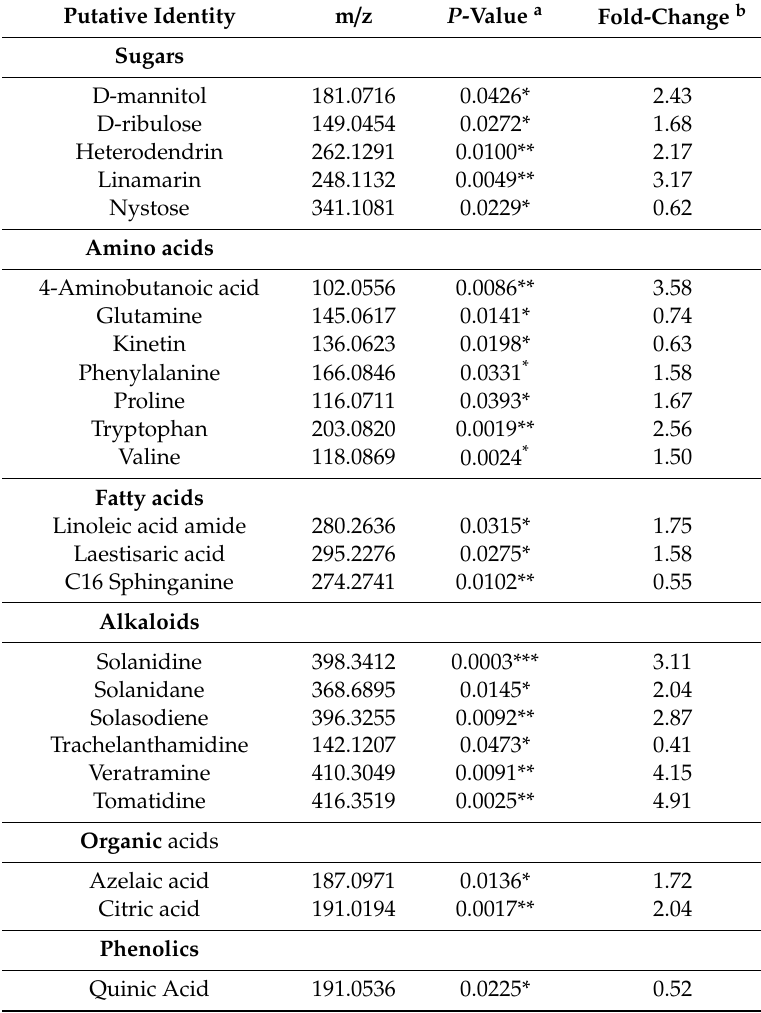
a p -values calculated using the student t-test showing significant di ff erences between the mean peak areas of the tolerant and susceptible cultivar groups. The asterisks indicate significant di ff erences between the two cultivar groups (* p ≤ 0.05; ** p ≤ 0.01; *** p ≤ 0.001). b Fold-change = mean peak areas of tolerant cultivars divided by mean peak areas of susceptible cultivars. Fold change > 1.5 shows the compound is upregulated in tolerant cultivars.